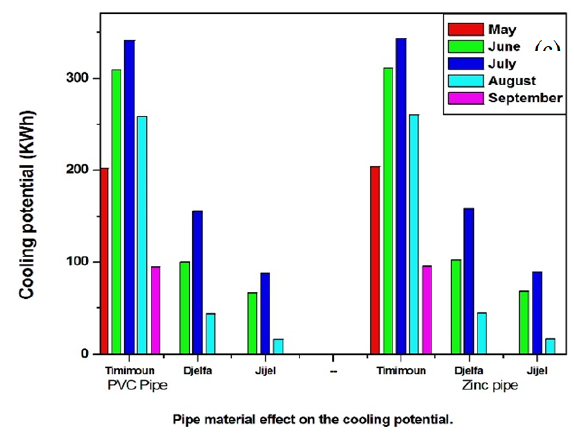
Figure 8. The monthly cooling energy provided by the EAHE for different dimensions: (a) Thickness effect, (b) Diameter effect, (c) pipe material effect.